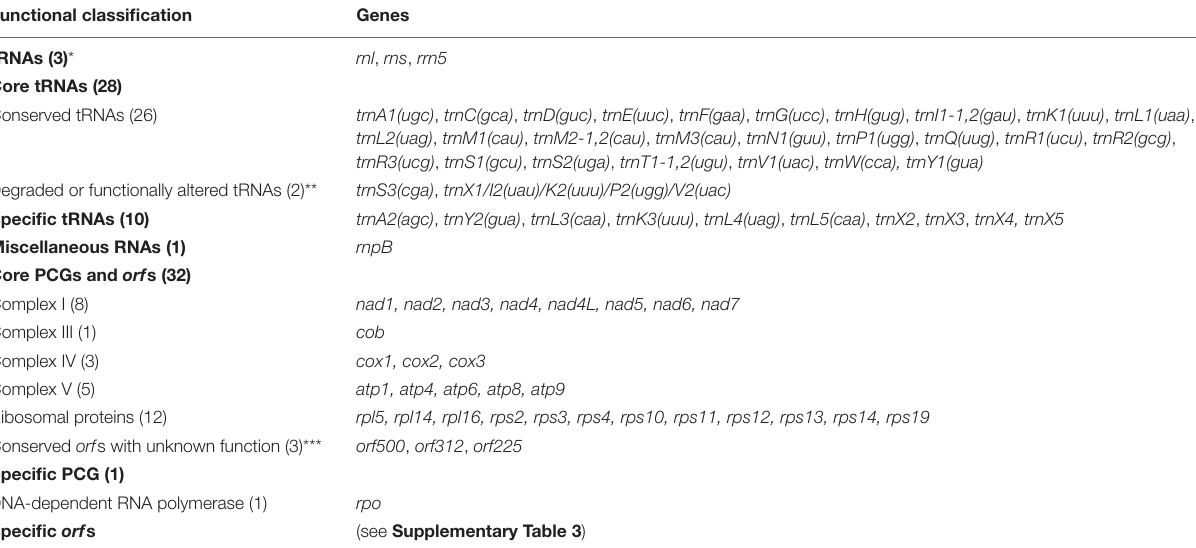
TABLE 2 | Functional classification of genes (including orf s) identified among these 33 ulvalean mitochondrial genomes. Functional